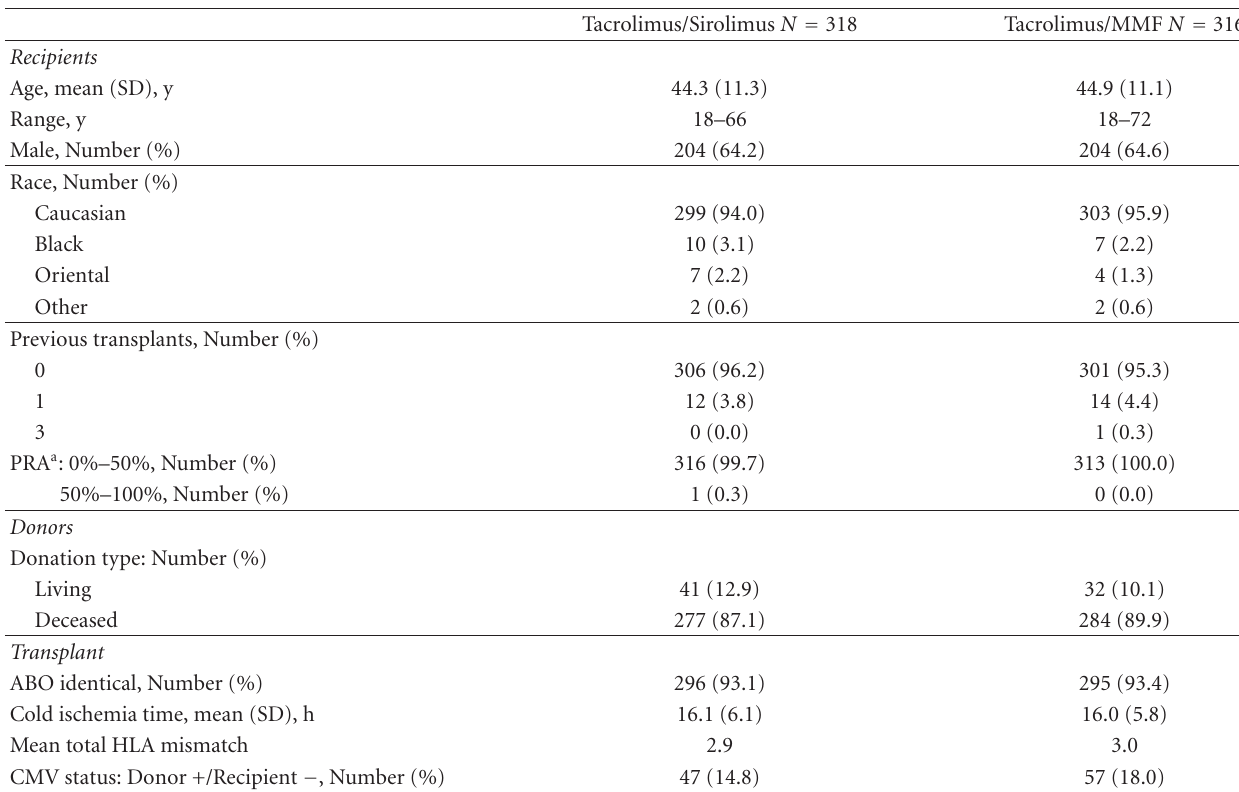
Table 1: Patient Demographics and Baseline